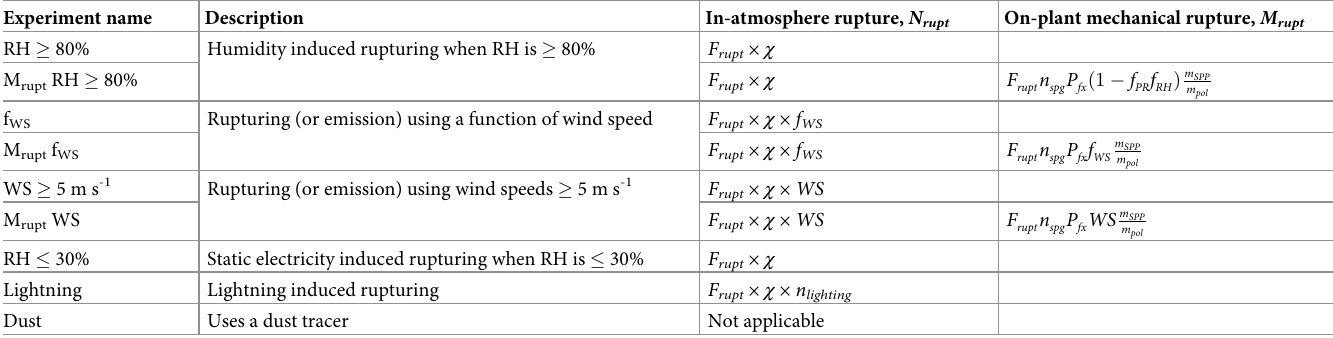
Table 1. Thresholds and variables used in each of the model experiments.